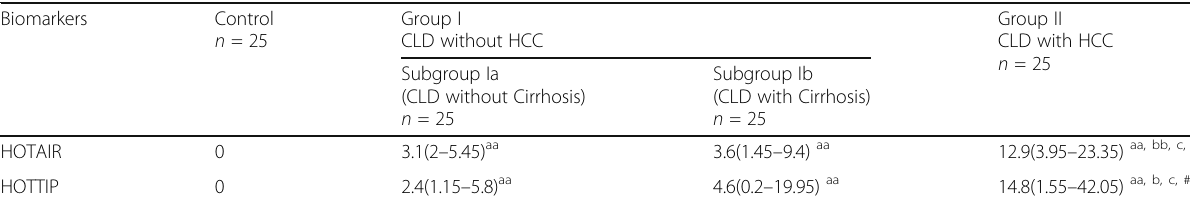
Table 4 Biomarkers gene expression in the studied groups